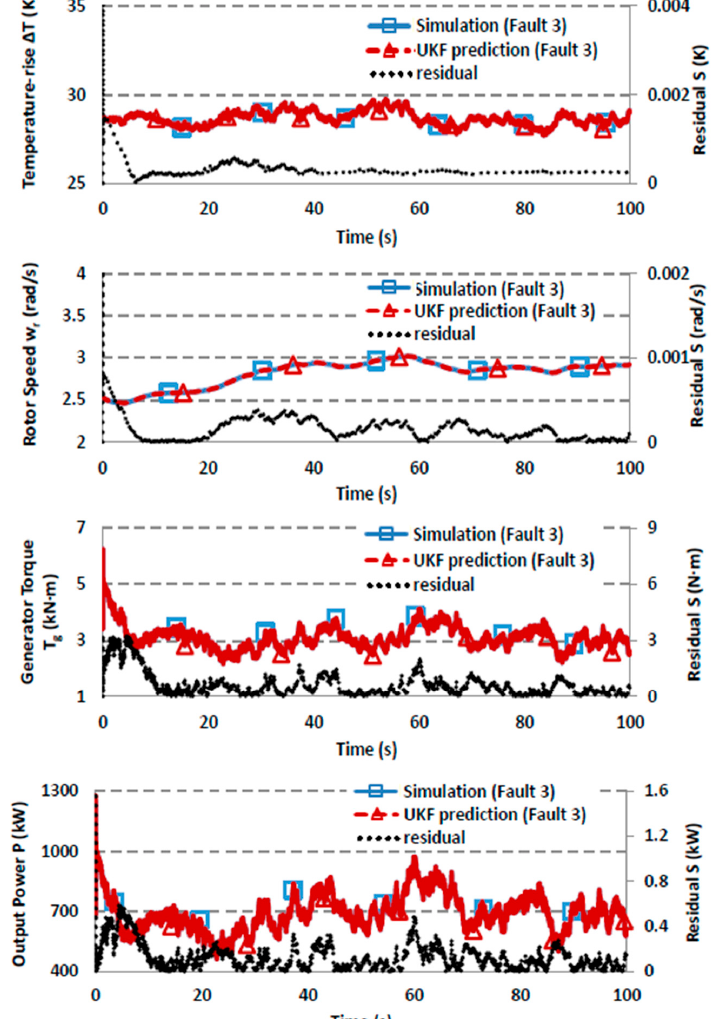
Figure 8. Comparison results of simulation and UKF prediction for a WT in Fault 3.